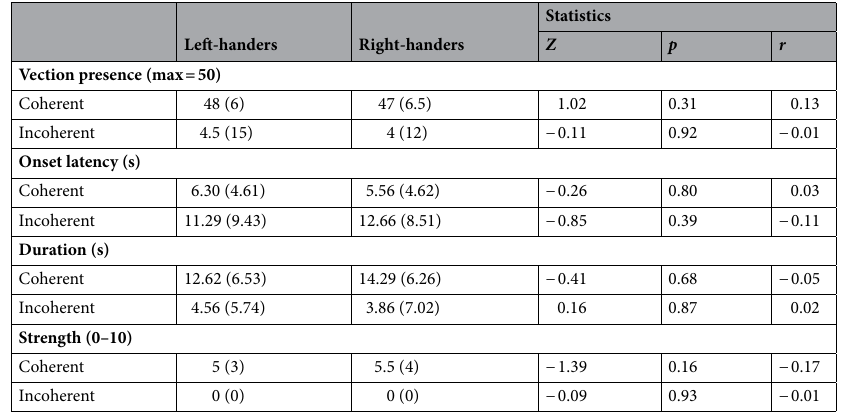
Table 1. Behavioural measures of vection. Presents median values (interquartile range) and statistical results from left- versus right-hander comparisons, in coherent and incoherent conditions. No significant differences were observed between the two groups. All participants reported vection perception in the coherent condition, whereas only a few subjects reported vection perception in the incoherent condition. Further, the vection experienced in the incoherent condition had longer onset latencies, shorter durations, and weaker subjective strength reports, when compared to the vection experienced in the coherent condition. Z = z-statistic, p = p-statistic, and r = effect size.